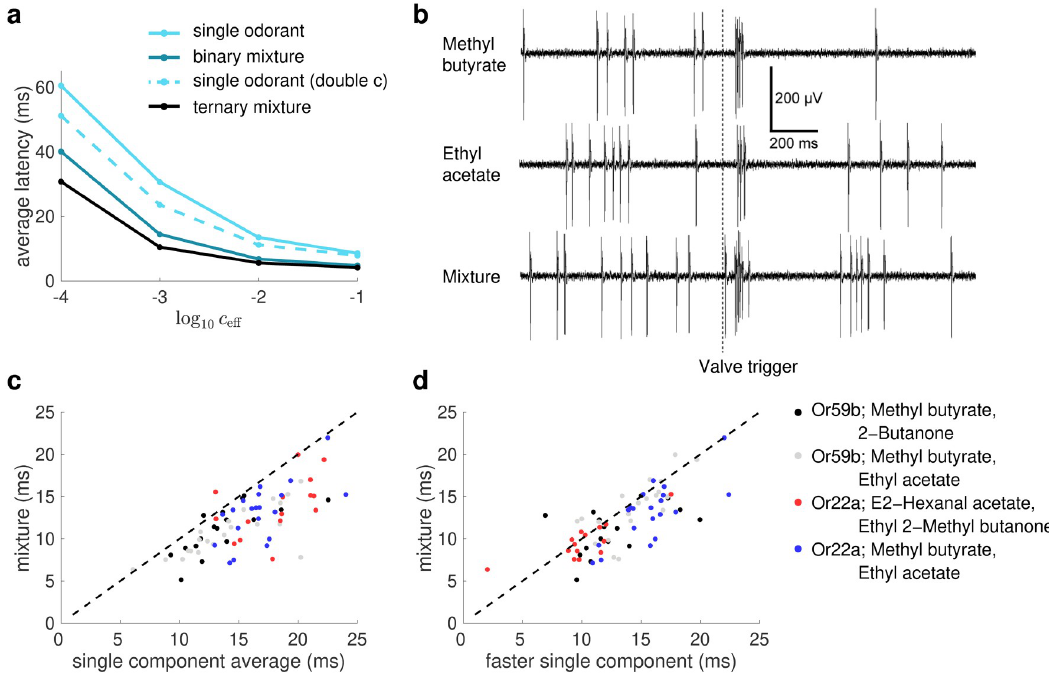
Fig 5. ORN first-spike latency for single odorants and mixtures. ( a ) The average first-spike latency predicted by our model ORNs decreases with the number of components in the odor stimulus. This effect is most pronounced when the stimulus concentration is low. The shorter first-spike latency for mixtures cannot be fully explained by the higher number of odor molecules in stimuli with more components compared to their counterparts with less components at the same concentration, since the latency for binary mixtures (dark cyan) is lower than that for a single odorant with doubled concentration (dashed line). Please note that all odor- receptor combinations with latency greater 100ms were taken to be 100ms when we calculate the average latency. ( b ) Example voltage traces obtained from recordings from an ab2 sensillum stimulated bymethyl butyrate, ethyl acetate and their mixture. The traces are filtered by a 100 to 3000 Hz bandpass. Large spikes belong to the OR59b-expressing ORN. ( c ) Recorded first spike latencies from Drosophila ORNs for binary mixtures and average latencies of their constituent components at doubled concentration, for 73 different animal-odor-receptor combinations. For the majority combinations (70 out of 73), the latency for mixtures is smaller than the average latency for the two components on their own. ( d ) Same as (c) but the comparison is made between mixtures and their constituent components with shorter latency at doubled concentration. The latency for mixtures is still smaller for most combinations (57 out of 73). The total number of measuremens for black/gray/red/blue is